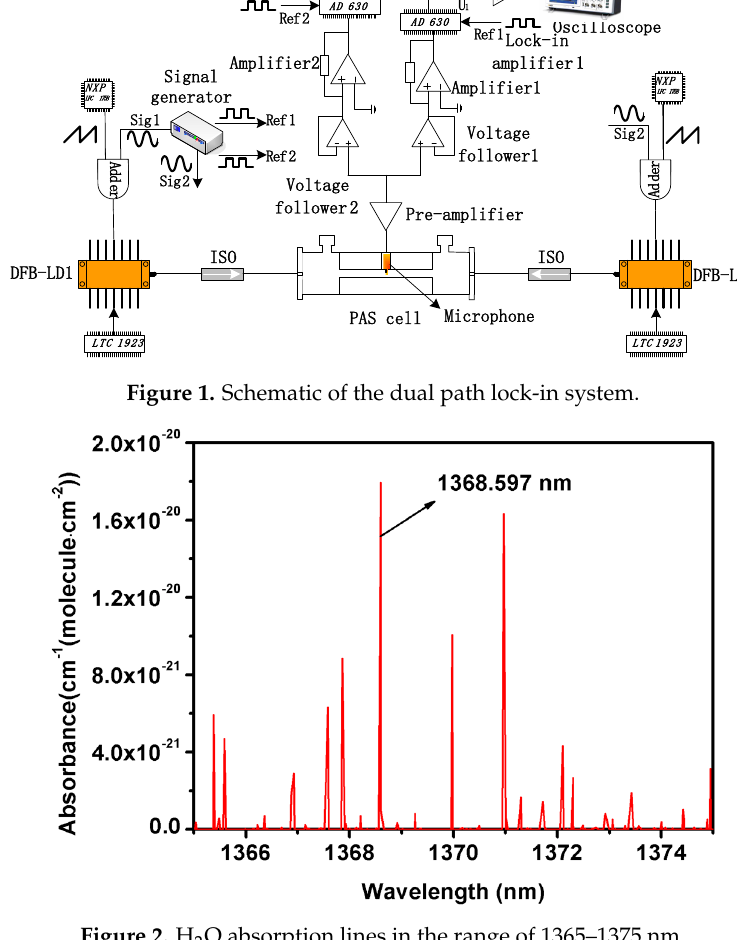
Figure 2. H 2 O absorption lines in the range of 1365–1375 nm.